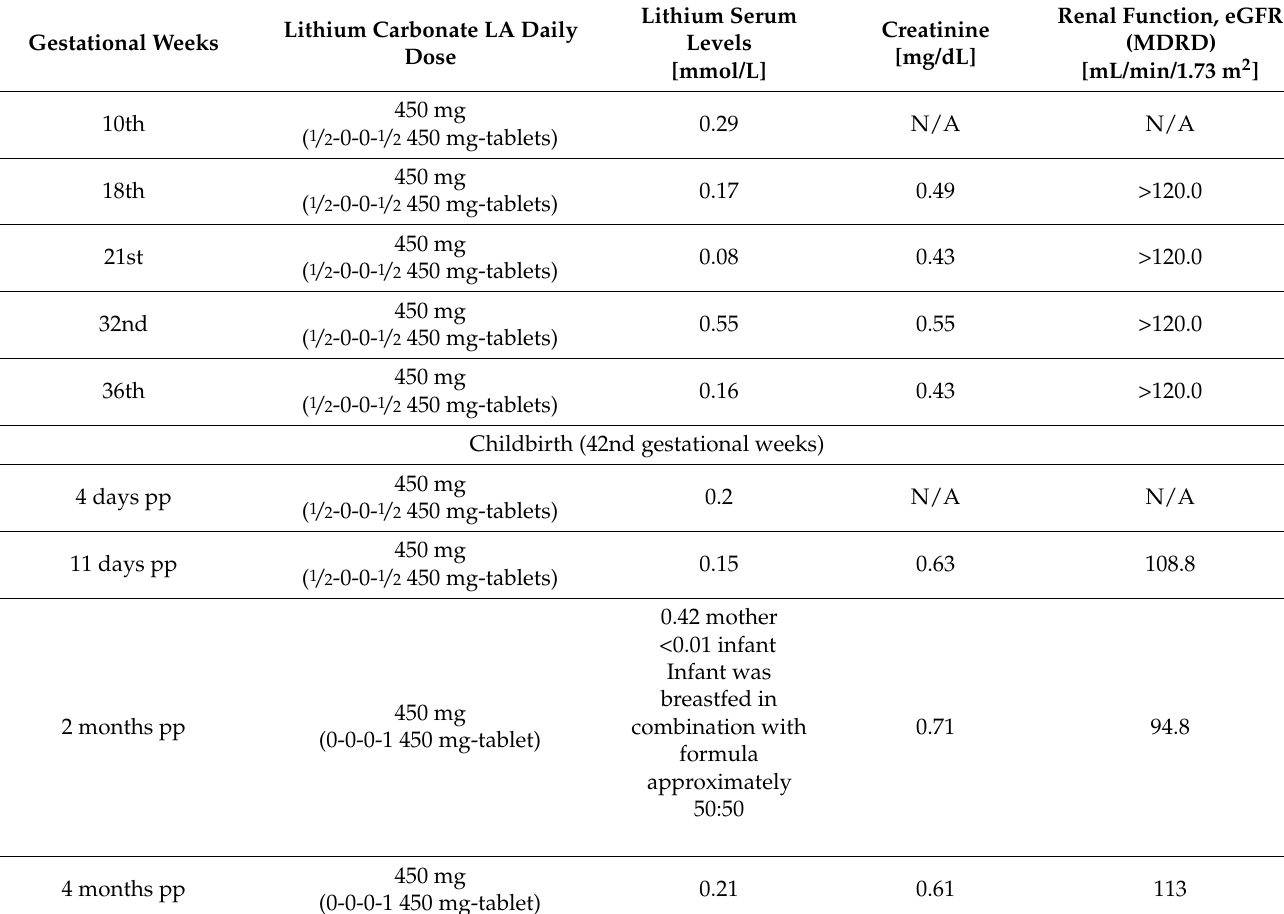
Table 2. Clinical data case